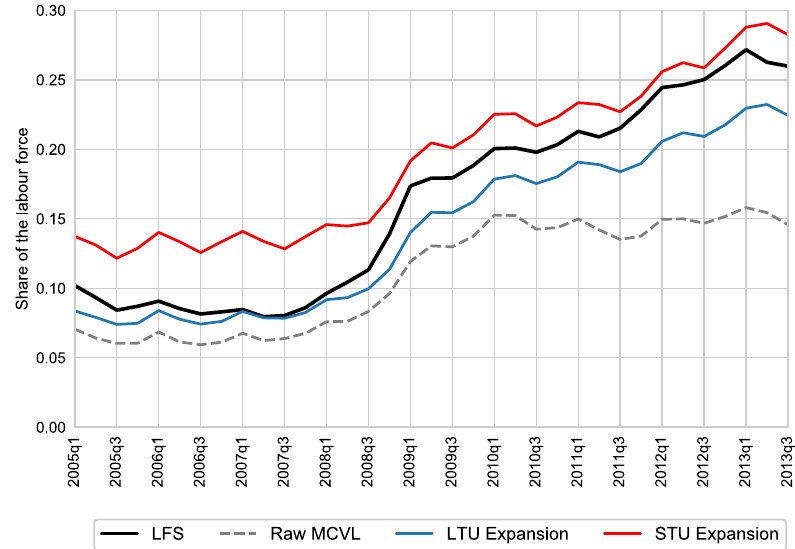
Fig. 8 Unemployment rates—short gaps expansion. Source : MCVL and the LFS